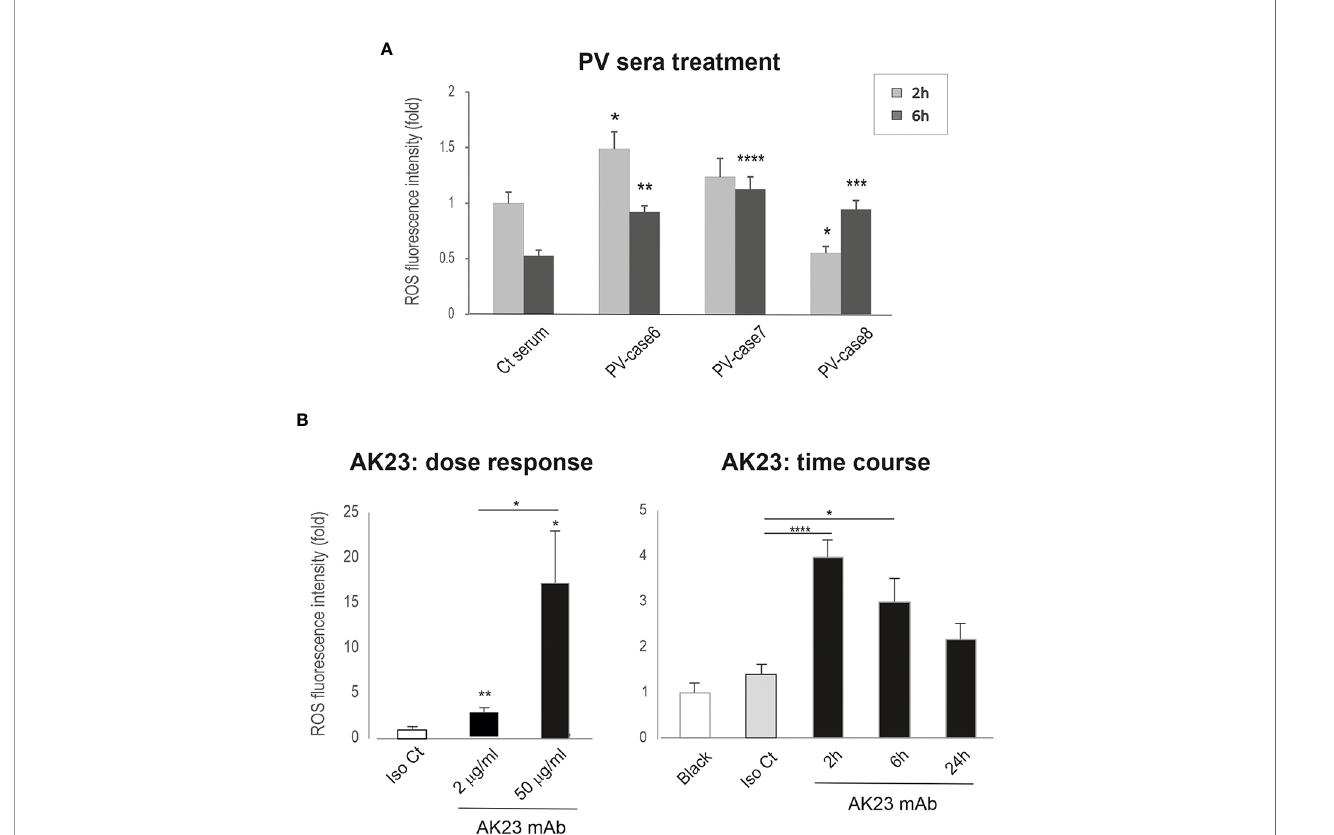
FIGURE 4 | Keratinocytes treated with PV sera and AK23 against Dsg3 shows transient ROS overproduction. Oral keratinocytes OKF4 seeded at approximately 70% con fl uent density in 96-well plate ( i.e. ~1x10 5 cells per well) in KSFM overnight before treated with PV sera (40% in KGM) (A) (pooled from 2 out of 3 independent experiments) and AK23 (B) (at least 2 experiments) with elevated concentrations or for increasing periods up to 24 hours. Iso Ct: Isotype control IgG1. Cells were then incubated with CellRox reagent (5µM) for 30 minutes before brief washing with PBS followed by image acquisition with an INCA 2200 Analyzer system straightaway. Transient increase of ROS was detected in cells treated with PV sera or AK23 compared to the respective controls, with a dose-dependent response for AK23 (n=25 automated fi elds/well, mean ± SEM, one-way ANOVA, *p < 0.05, **p < 0.01, ***p < 0.001, ****p < 0.0001). Of note, a few wells treated with PV sera had a large proportion of cells lost and were excluded from the analysis. The data shown were representative of three independent